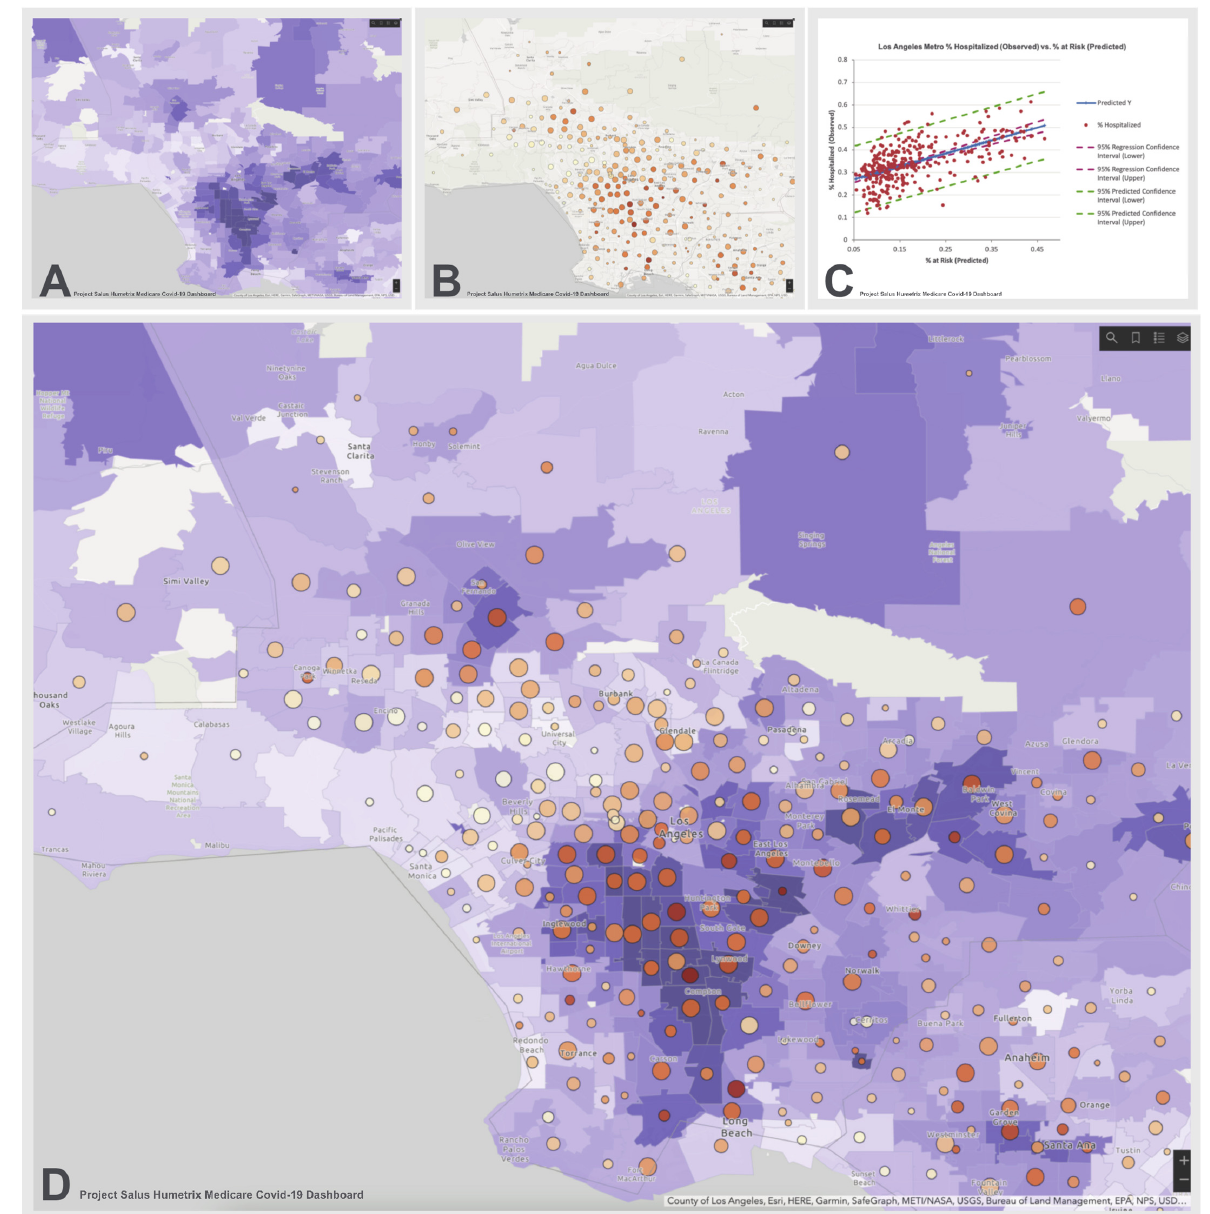
Figure 4 . Los Angeles COVID-19 Hospitalization Risk Map. Panel A shows the percentage of the Salus cohort with a predicted probability of hospitalization when diagnosed with COVID-19 of over 0.55 on a light blue to dark lavender color scale. Panel B shows the cumulative number of hospitalizations per zip code (increasing size of circles denotes a higher hospitalization count) with the percentage of cases requiring hospitalization shown on a beige to dark orange scale. Panel C shows a linear regression analysis of the case hospitalization rate ( Y axis) as a function of the risk level in each zip code (regression R 2 = 0.35); Panel D is an overlay of panel B on Panel A and demonstrates that zip codes with the highest predicted probabilities of hospitalization with COVID-19 tend to have higher observed percentage of cases requiring hospitalization and vice versa.